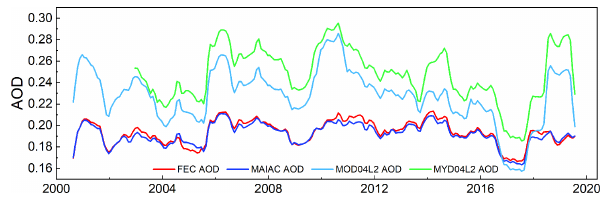
Figure 5. The long-term change trends of four AOD products ob- tained by removing seasonal